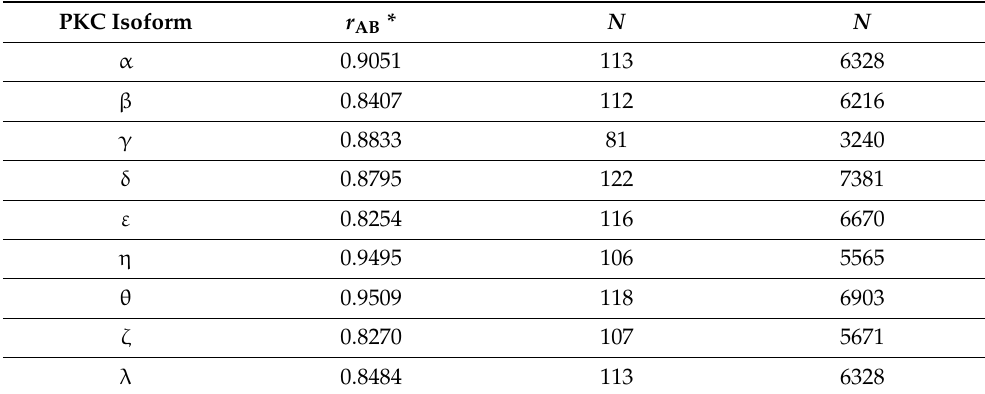
Table 1. Pearson correlation coefficients, r AB , of mirror tree analyses of coevolution of the Na + , K + -ATPase α 1 subunit and isoforms of PKC. N is the number of common organisms, and n is the number of pairwise combinations of the common organisms.